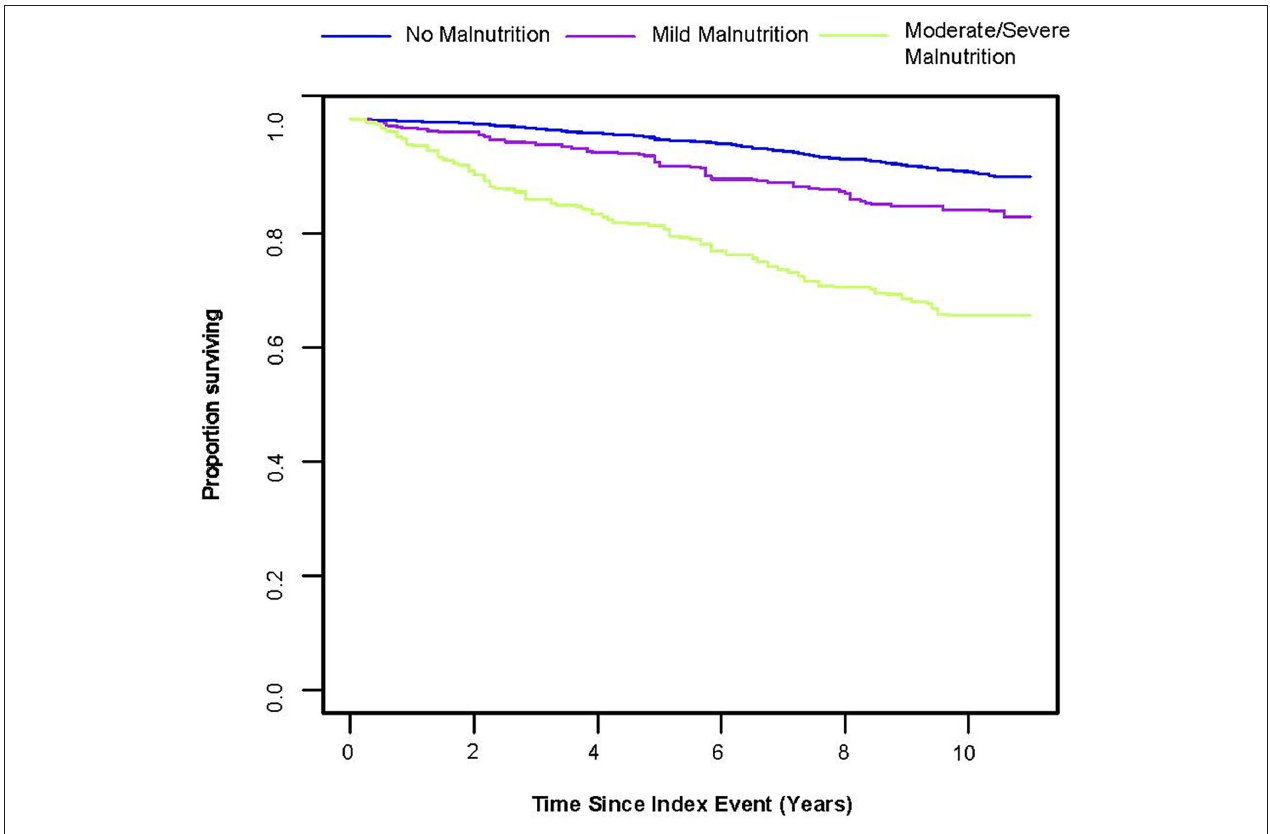
FIGURE 2 | Kaplan-Meier Survival Estimates for long-term all-cause mortality (weighted).